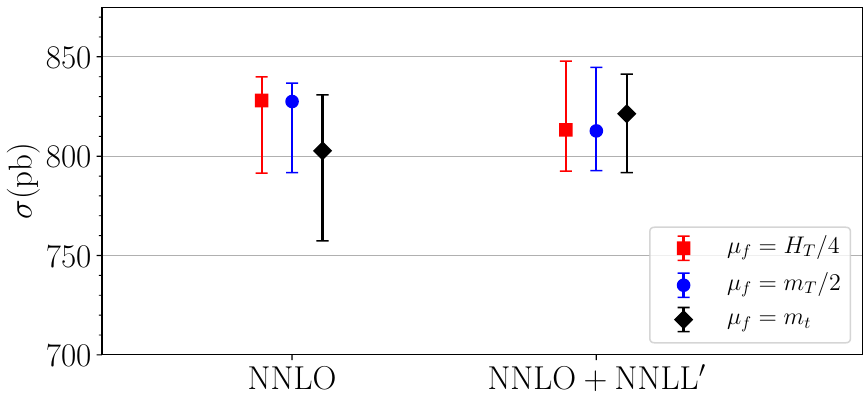
Figure 7 . Predictions for the total top-pair production cross section at the LHC with p s = 13 TeV, where the error bars represent perturbative uncertainty estimates through scale variations. The method for obtaining results and the uncertainty estimates at di(cid:11)erent values of (cid:22) f is described in the second to last paragraph of section